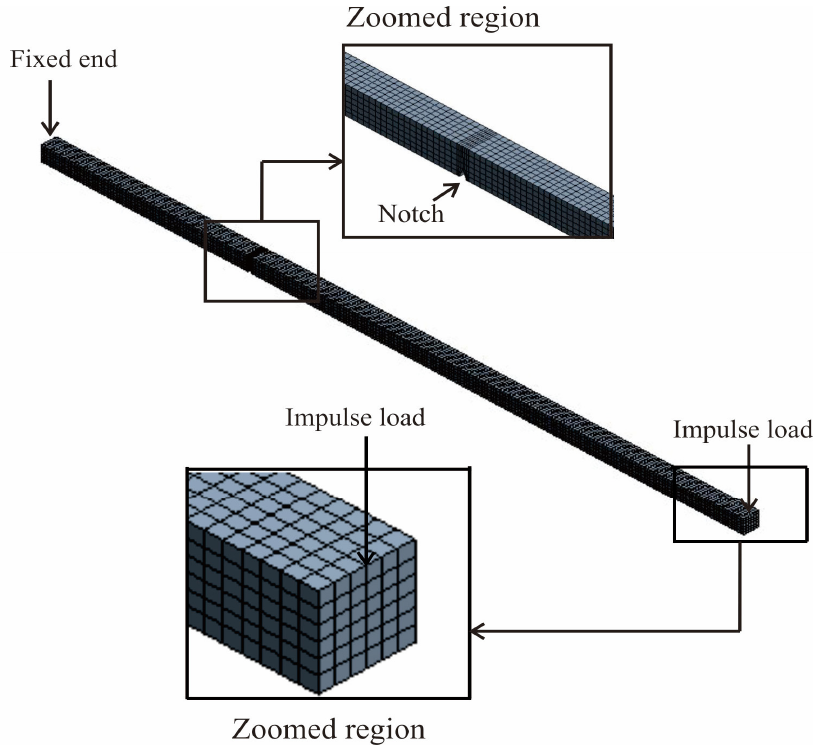
Figure 4. Beam with meshes assigned for FEA analysis. Table 2. Comparison of natural frequencies calculated from FE model and analytical solution.